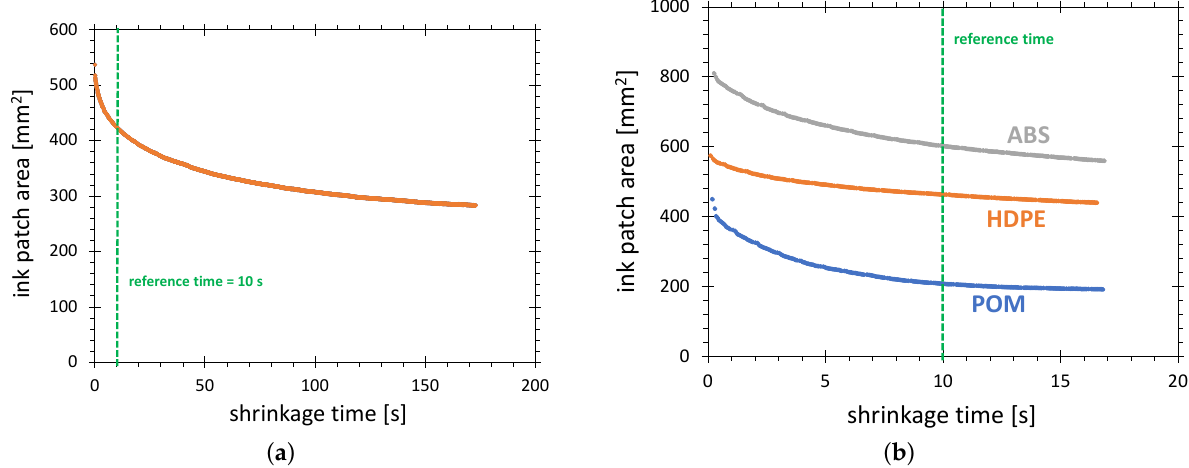
Figure 5. Shrinkage characteristics of the 58 mN/m test ink patch ( a ) taken for 3 min on HDPE, and ( b ) taken 17 s on three substrate materials: ABS, HDPE and POM. The discharge configuration C was